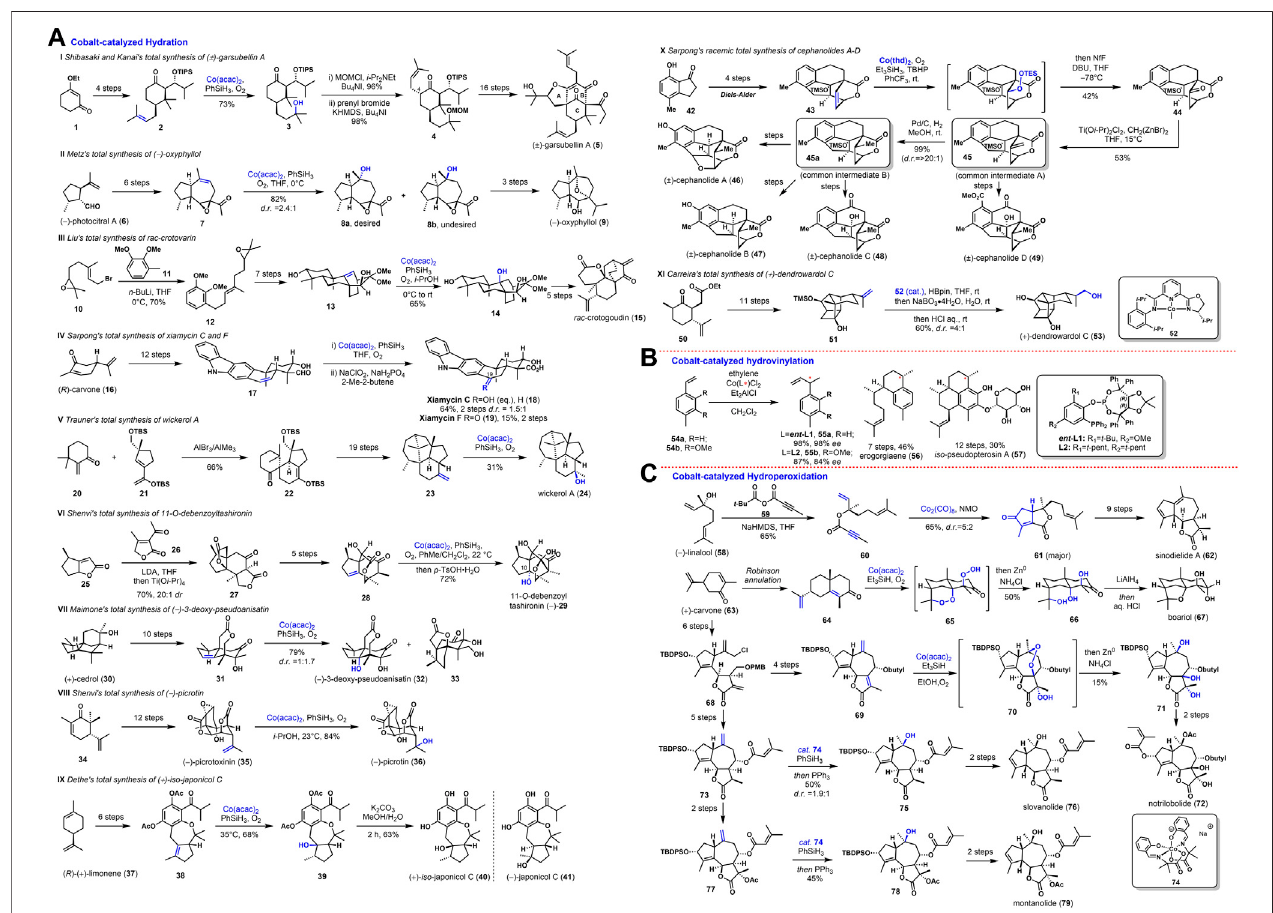
FIGURE 1 | Cobalt-catalyzed Hydration, Hydrovinylation, and Hydroperoxidation.